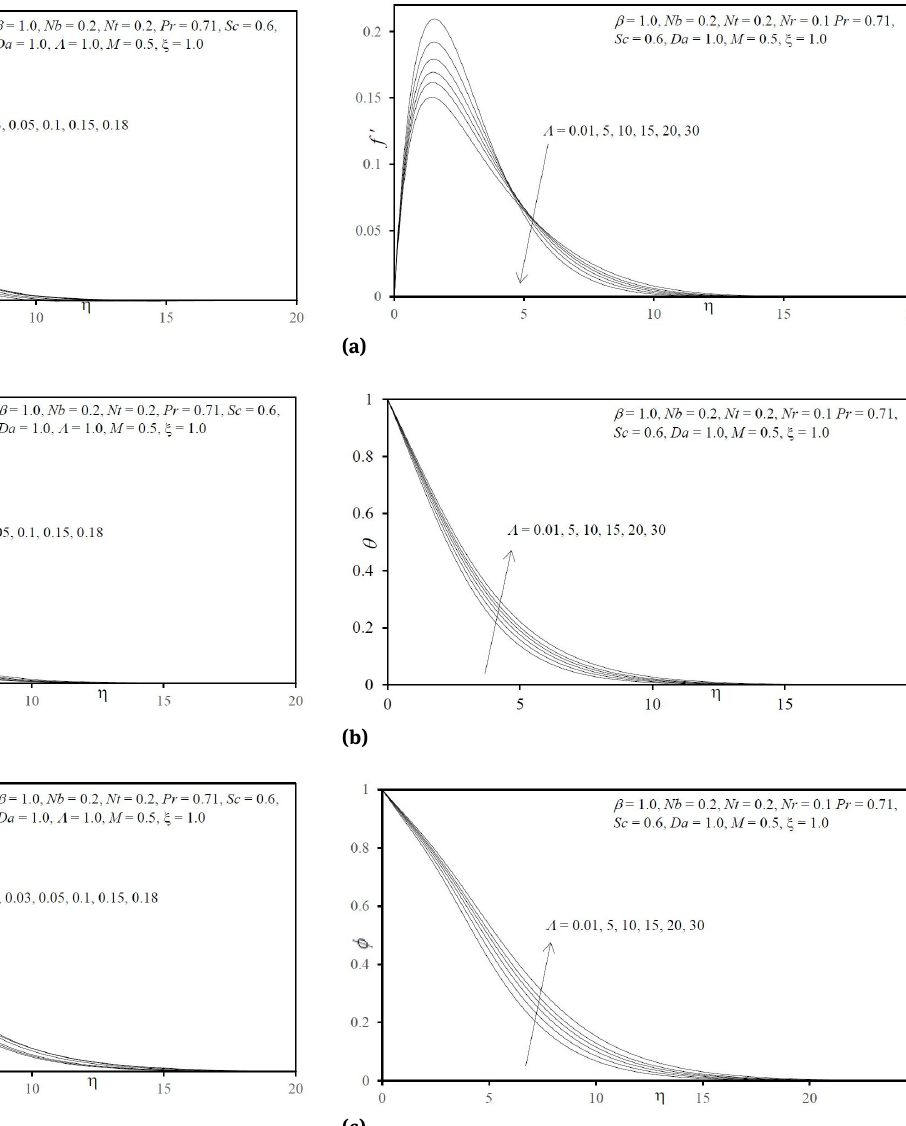
Fig. 7: (a) Influence of Λ on Velocity Profiles; (b) Influence of Λ on Temperature Profiles; (c) Influence of Λ on Concentration Profiles fluid regime, thereby accounting for the elevated concen- tration (nano-particle) as shown in Fig. 5(c). For Nt = 0.1, a monotonic decay in nano-particle concentration from the wall of the cylinder into the free stream. However, for Nt > 0.1, a concentration peak is observed further from the sur- face of the